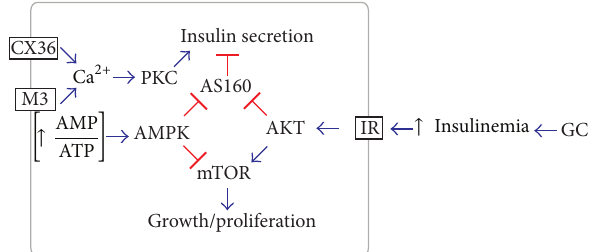
Figure 7: Hypothetical scheme of the main signaling pathways modulated in pancreatic 𝛽 -cells by the in vivo glucocorticoid treatment. Decreased insulin sensitivity in peripheral tissues leads to hyperinsulinemia, which stimulates the insulin signaling in the pancreatic 𝛽 -cell. Activated AKT inactivates the AS160, releasing its inhibitory effect on insulin secretion (functional compensation). Also, pAKT activates mTOR, favoring 𝛽 -cell growth (structural compensation). In parallel, dephosphorylated AMPK, which may reflectalowAMP : ATPratio,favorstheactivationofmTORbyAKT and suggest that AS160 inhibition is modulated by the insulin sig- naling, rather than AMPK signaling. An increased parasympathetic drive through muscarinic receptor (M3) and/or increased 𝛽 -cells communication, through CX36 channels, may increase cytosolic Ca 2+ and activates PKC, which stimulates insulin secretion. → represents stimulations and ⊣ represents